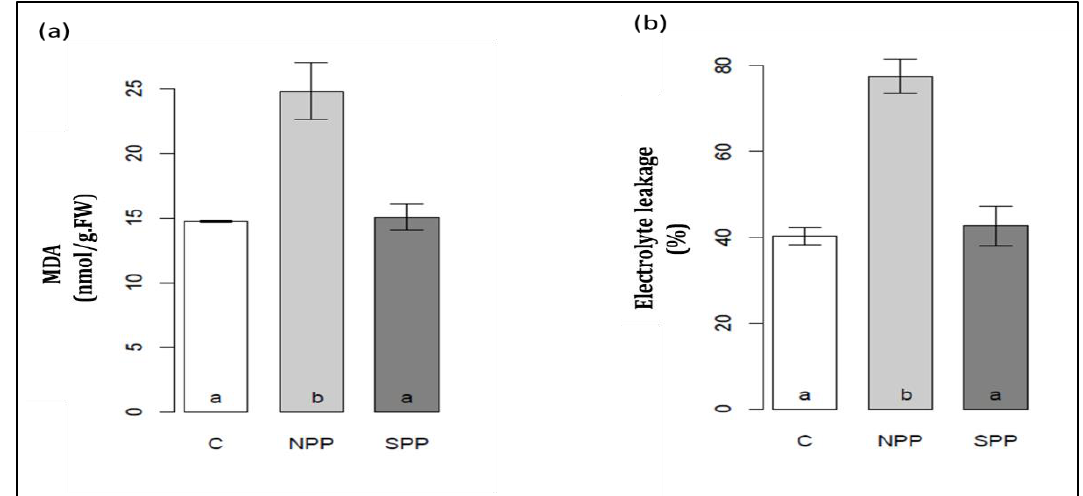
Figure 9. Changes in malondialdehyde, MDA ( a ), and electrolyte leakage, EC, percent ( b ) of olive leaves subjected to subsequent drought stress. Significant differences between the means (at p < 0.05, according to ANOVA) appear with different letters. Values are means ± standard error ( n = 6), where ‘ n ’ is the number of replicates for each group. Table 3. Effect of cross-tolerance on CAT, superoxide dismutase, SOD, and guaiacol peroxidase, GP, activities (U mg − 1 protein) of olive leaves subjected to subsequent drought stress. Significant differences between the means (at p < 0.05, according to ANOVA) appear with different letters. Values are means ± standard error ( n = 6), where ‘ n ’ is the number of replicates for each group.